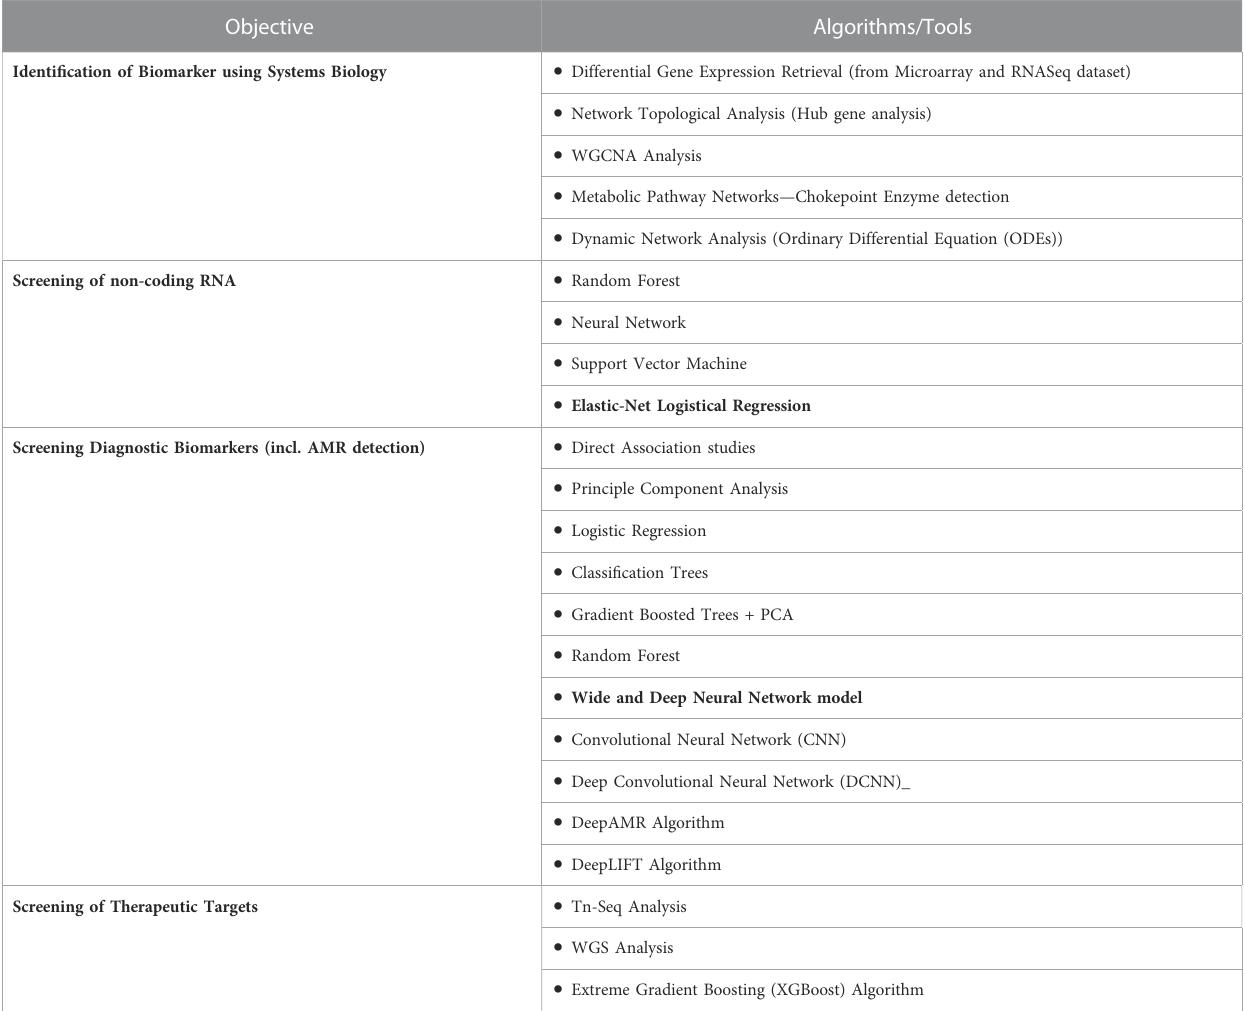
TABLE 2 Algorithms and tools used for screening and identi fi cation of biomarkers against